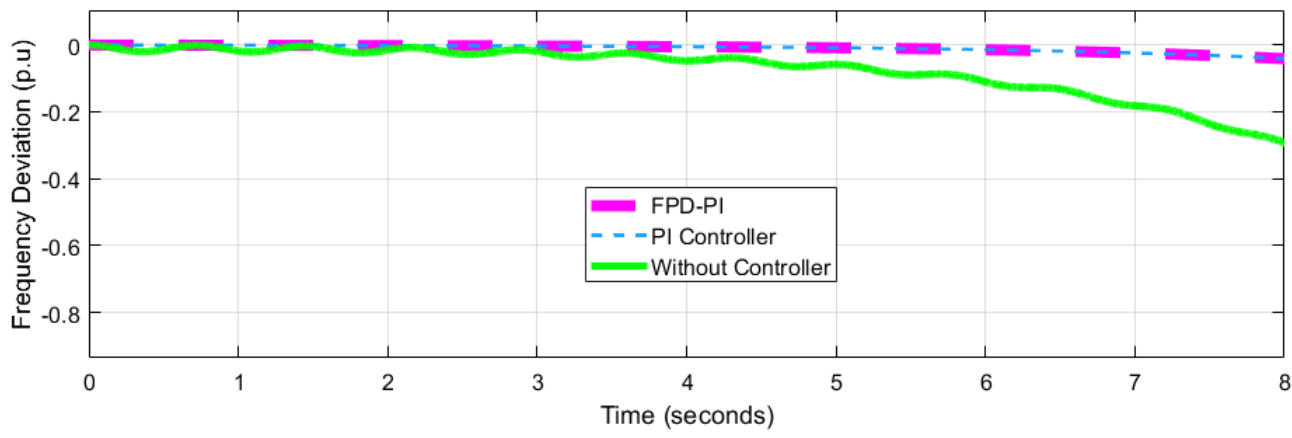
Figure 8. Case 1: frequency deviation at (K p = −1.9185, K i = −0.0030) for network 2.